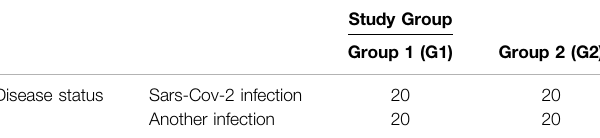
TABLE 1 | Overall design in the case study: transcriptomic changes due to Sars- Cov-2 infection. The table shows number of patients in each combination of study group/disease